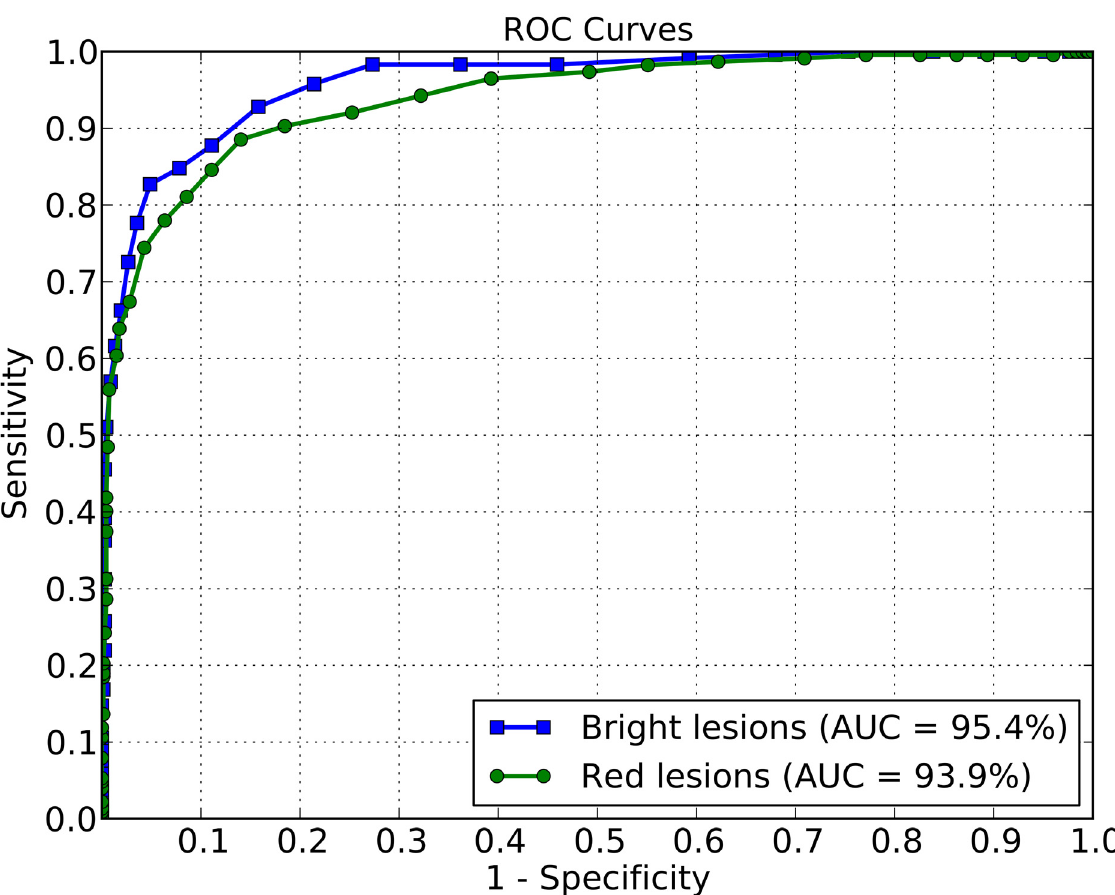
Fig 3. ROC curves. Training and testing images both from DR1